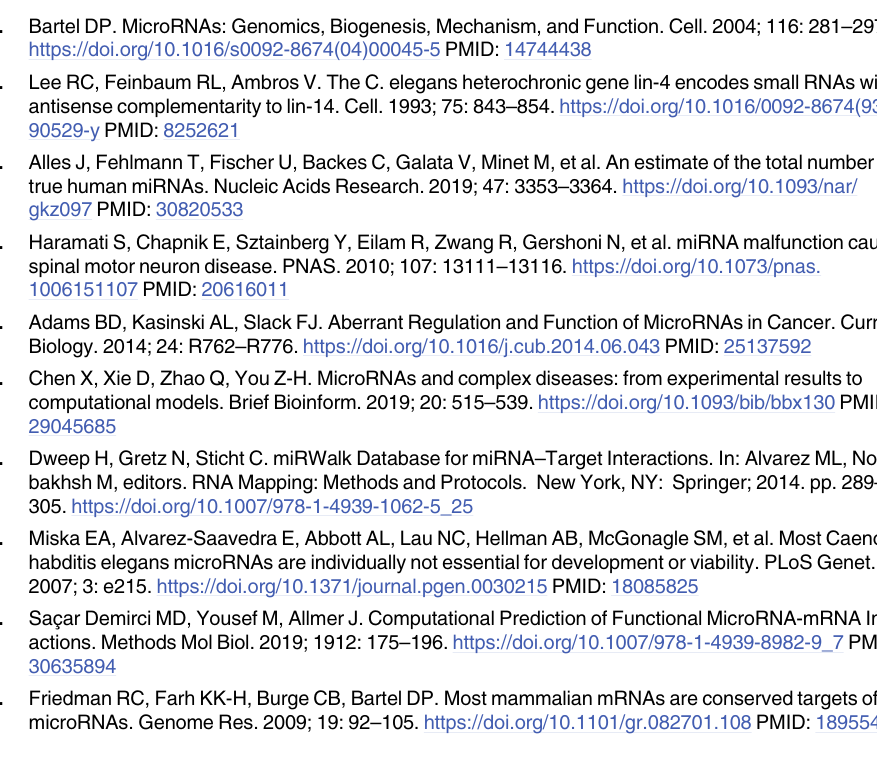
S3 Table. Subset of TargetScanHuman predictions filtered for over-represented miRNA families and REST targets. S4 Table. Number of target genes with at least one and more than one predicted binding site, for a particular miRNA